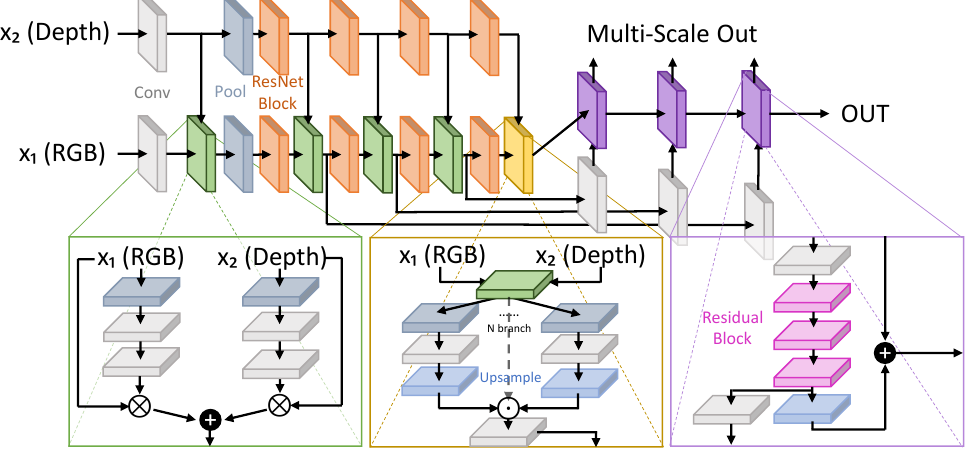
Figure 8. Two branches encoder architecture proposed in